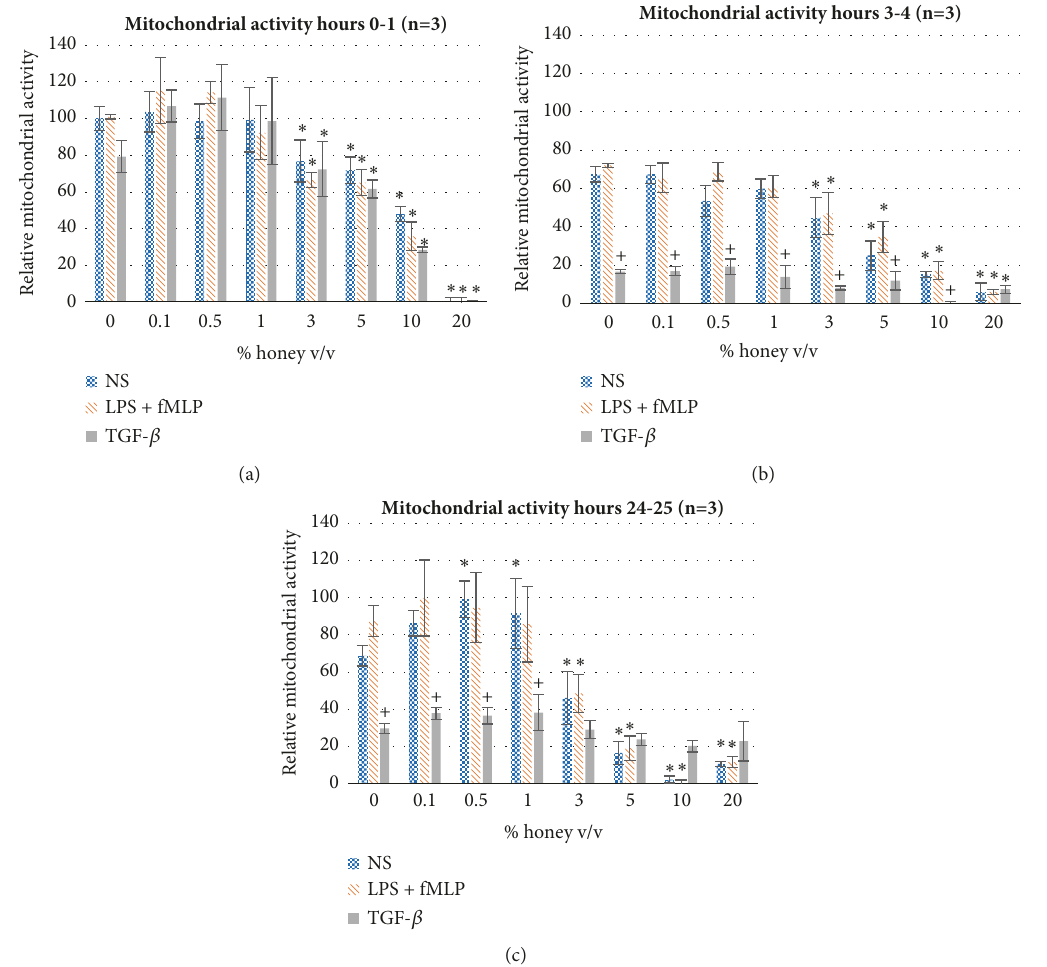
honey samples indicates that Manuka honey reduces this chemotactic response, decreasing the amount of migration to a level at or below the random walk level seen in the no fMLP control. The 20% honey sample had a significant decrease in the number of cells in both the top and bottom chambers, most likely due to the cytotoxicity of this honey concentration and the effect described above with respect to Figure